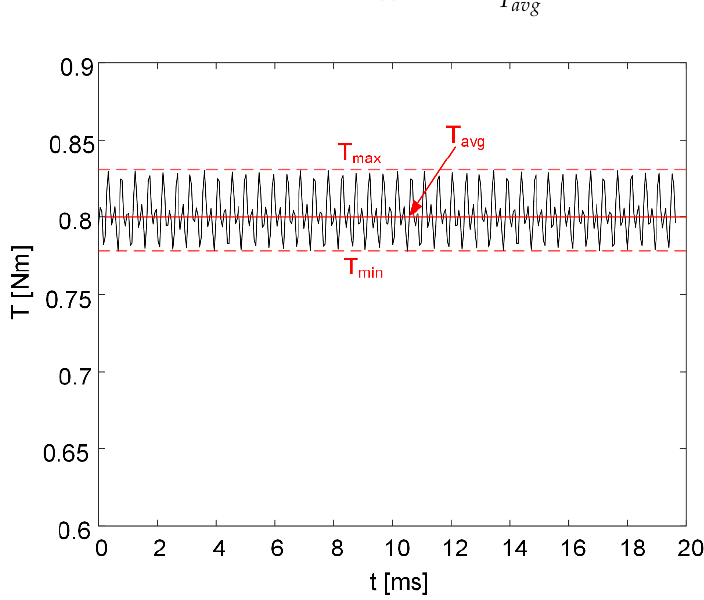
Figure 4. Motor torque at nominal current and optimum gamma angle.